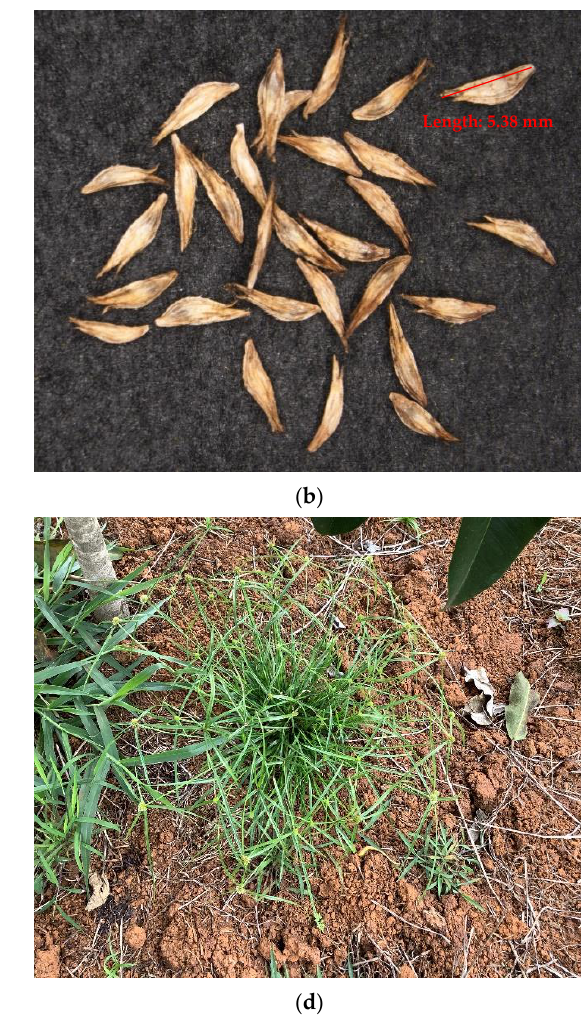
Figure 1. The invasive Navua sedge ( Cyperus aromaticus ); ( a ) mature flowering plants, ( b ) spikelets, ( c ) rhizomes and ( d ) mature plants in northern Queensland in Australia.